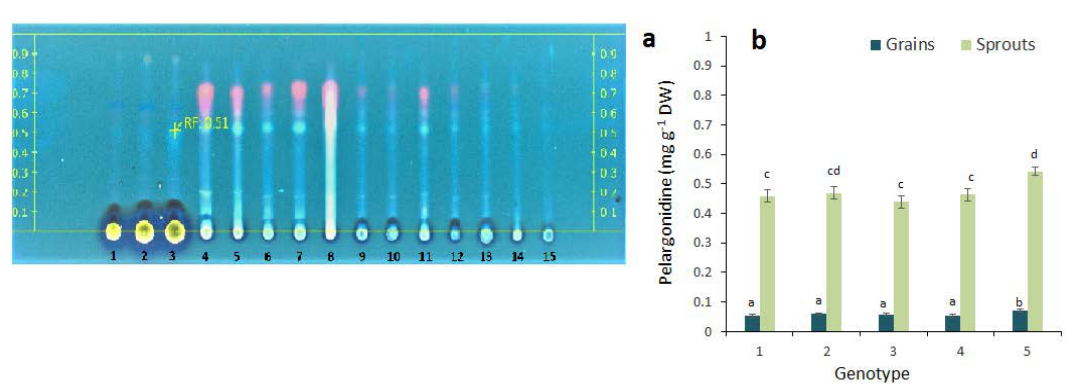
Figure 4. ( a ) HPTLC chromatogram of pelargonidin separation for the sprouts (tracks 4–8: track 4—Citrus yellow, track 5—KM 53-14 Blue, track 6—KM 178-14 purple, track 7—Skorpion Blue aleurone, track 8—PS Karkulka purple) and grains (tracks 9–13: track 9—Citrus yellow, track 10—KM 53-14 Blue, track 11—KM 178-14 purple, track 12—Skorpion Blue aleurone, track 13—PS Karkulka purple) extracts from colored wheat genotypes; standard mixture (tracks 1–3) (RF 0.51). ( b ) Pelargonidin contents in the grains and sprouts of colored wheat genotypes: 1—Citrus yellow, 2—KM 53-14 Blue, 3—KM 178-14 purple, 4—Skorpion Blue aleurone, and 5—PS Karkulka purple. The columns represent the mean values ± S.E. for five replicates. Statistically significant differences among treatments at each time are indicated by different lowercase letters (Duncan test; p <